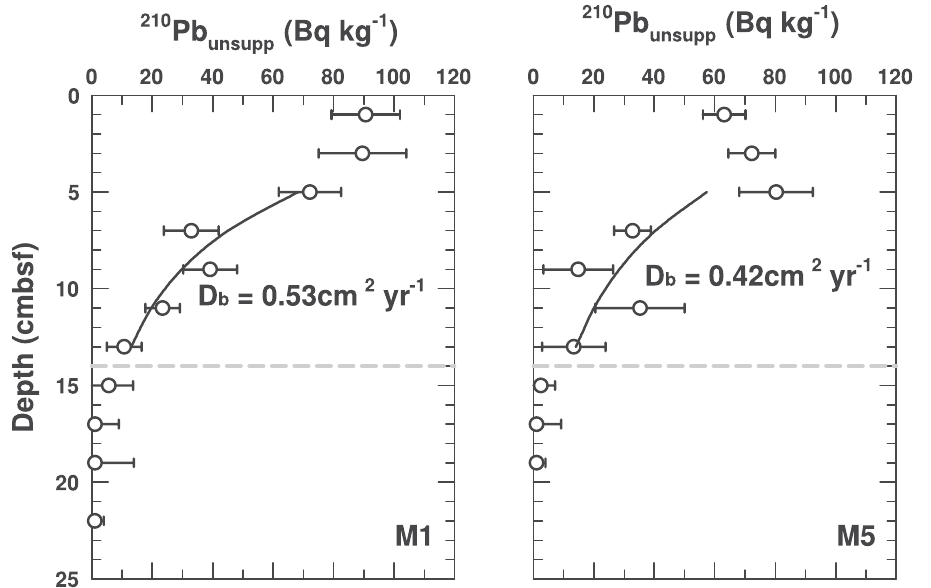
Figure 3. Modeled sediment mixing coefficients, D b , based on depth profiles of 210 Pb unsupp in the depth interval from 4–14 cmbsf at M1 and M5. Error bars indicate the standard deviation of 210 Pb unsupp within each depth sampled. The horizontal grey dashed lines indicate the minimum depth of macrofaunal sediment reworking (0.14